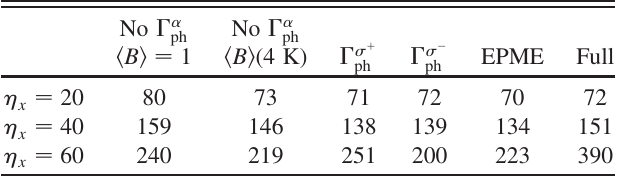
Figs. 10–13). All numbers are in units of (cid:8) eV , and note that the broadening here is independent of (cid:3) (cid:1) þ a ph column gives the full polaron ME result [Eq. (11)].